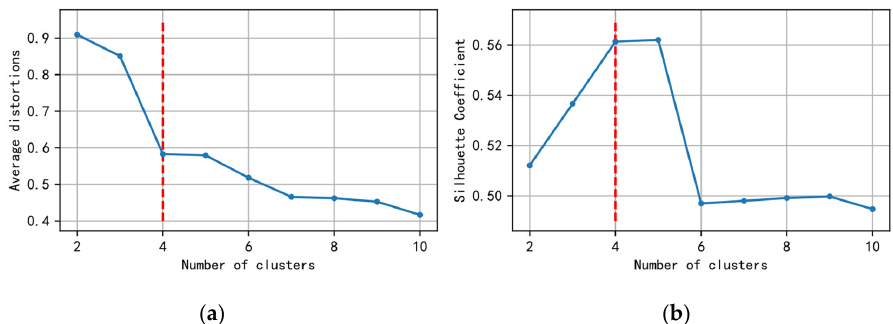
Figure 3. ( a ) Selection of cluster number with the elbow method and ( b ) validation of clustering performance using the silhouette coefficient.